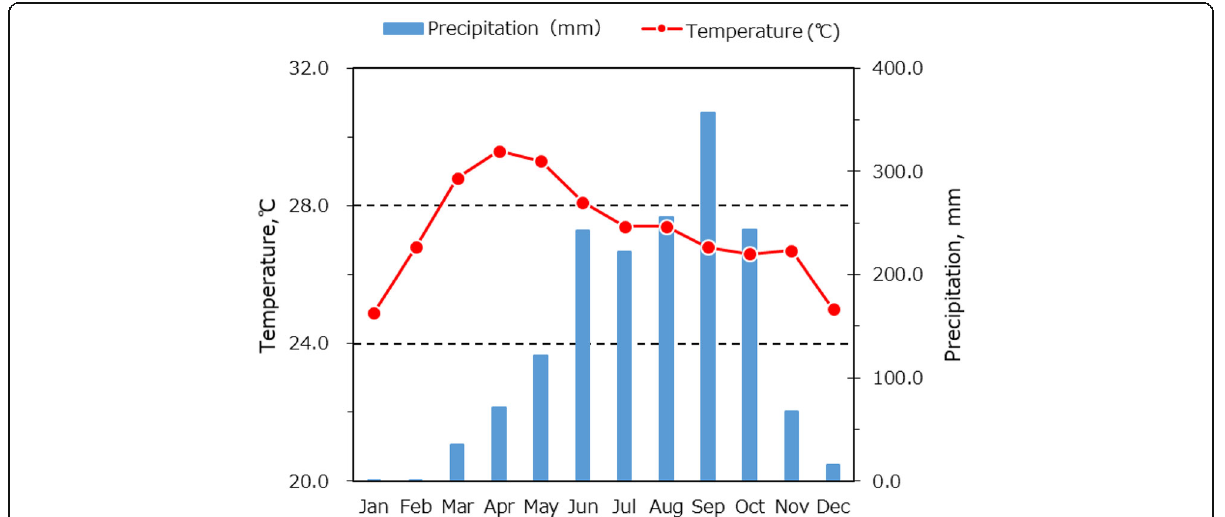
Fig. 4 Monthly average temperature and precipitation based on the meteorological observation between 2011 and 2016 at Angkor Wat temple (AMOS)